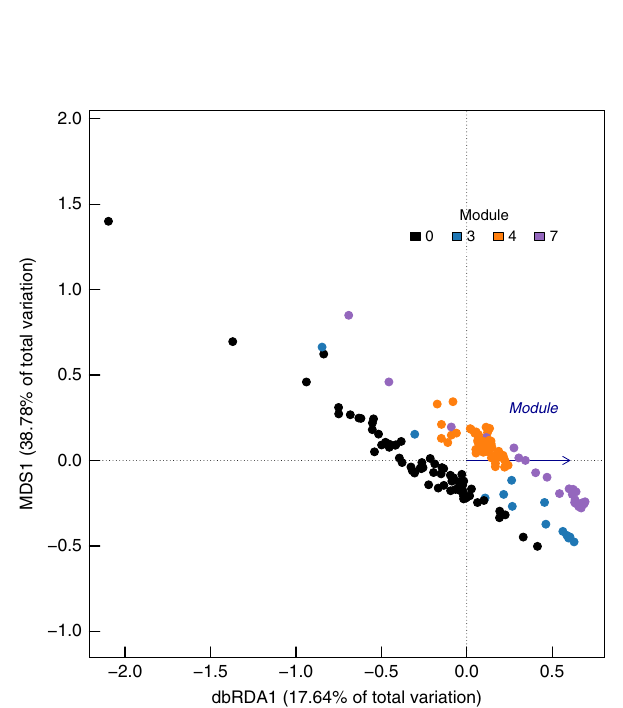
Fig. 5 Modules of the core network are functionally distinct. Constrained distance-based redundancy analysis shows a clear separation of the functional pro fi les of sponges belonging to different network